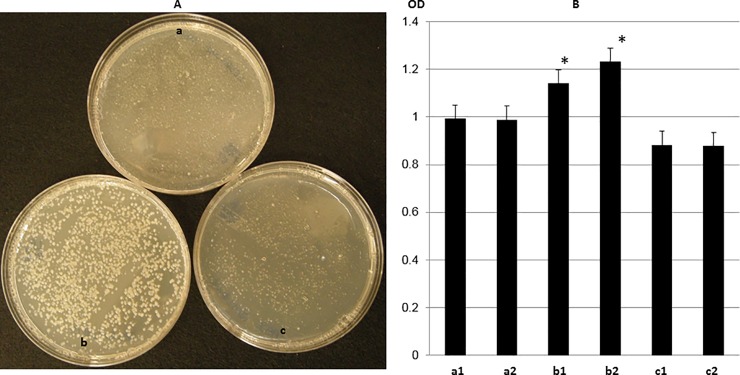
Growth of A. tumefaciens with a) pMON83937, WT-RepB; b) pMON83937-RepBY299H, and c) pMON83937-repBT486C
silent mutation. Panel A) Colony size on solidified medium. Panel B) Growth rate in liquid medium (shown as OD at A600 on the Y axis): a1, a2; two colonies from pMON83937, b1, b2; two colonies from pMON83937-RepBY299H, c1, c2, two colonies from pMON83937-repBT486C.